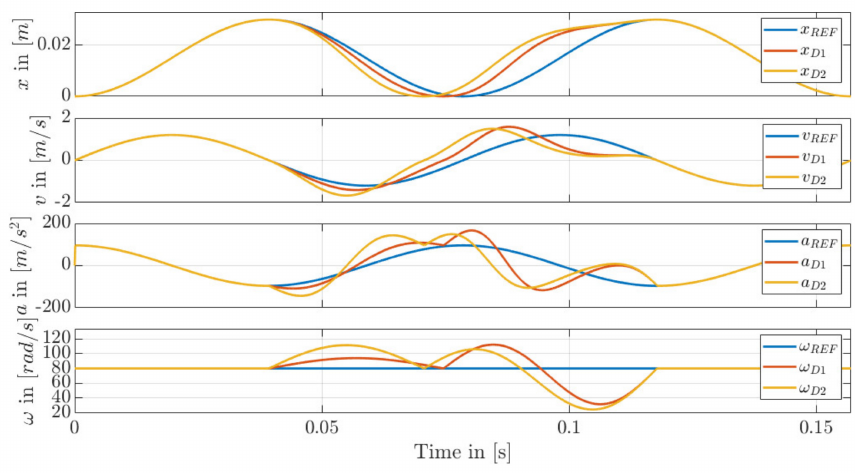
Figure 13. Comparison between the reference curve and stroke amplitude variation in the operating point ω = 80 rad/s, x peak = 0.03 m, T 2 = 0.225 · T p , T 3 = 0.275 · T p , ∆ ω T 3 = 40 rad x peak = 0.03 m, T 2 = 0.2 · T p , T 3 = 0.3 · T p , ∆ ω T 3 = 40 rad